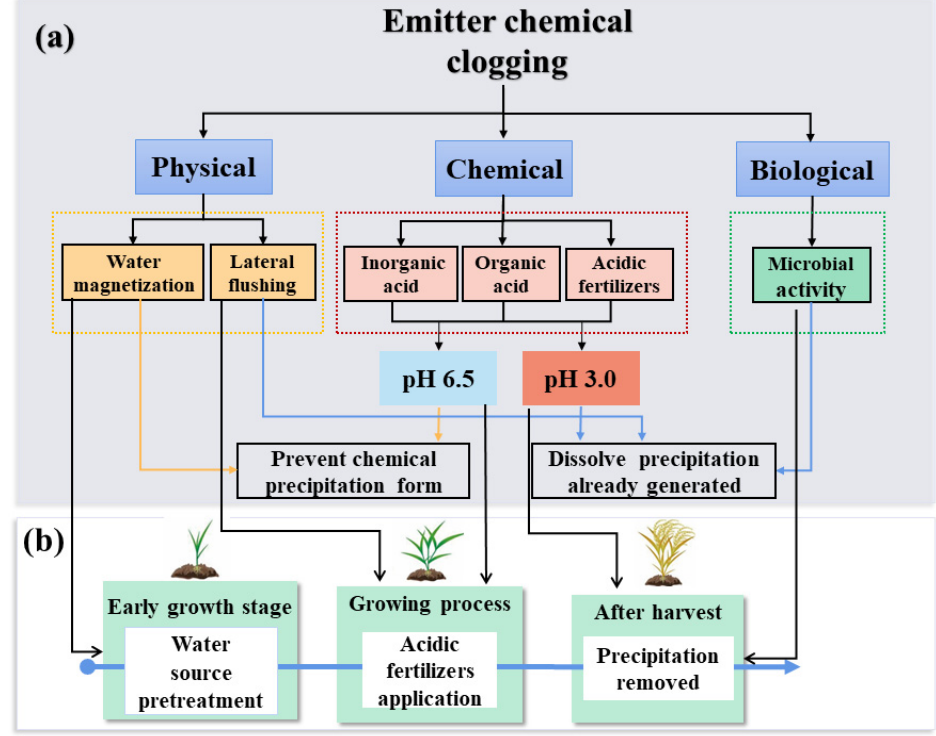
Figure 7. The control method for emitter chemical clogging. ( a )The control methods mainly depend on physical, chemical, and biological technologies to prevent and eliminate the chemical clogging. ( b ) Different methods to prevent and eliminate chemical clogging under different irrigation water quality during the crop growth cycle.